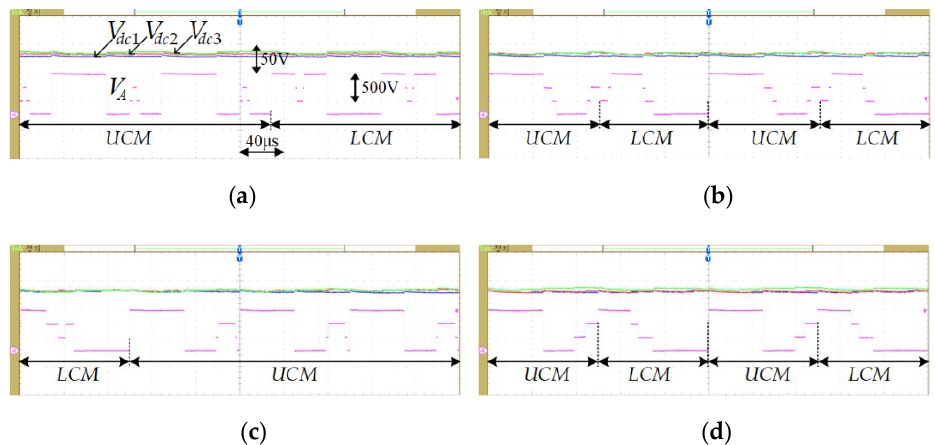
Figure 22. Voltage-balancing performances for the ( a ) middle, ( b ) edge, ( c ) rear, and ( d ) end sags when P O = 1000 W.